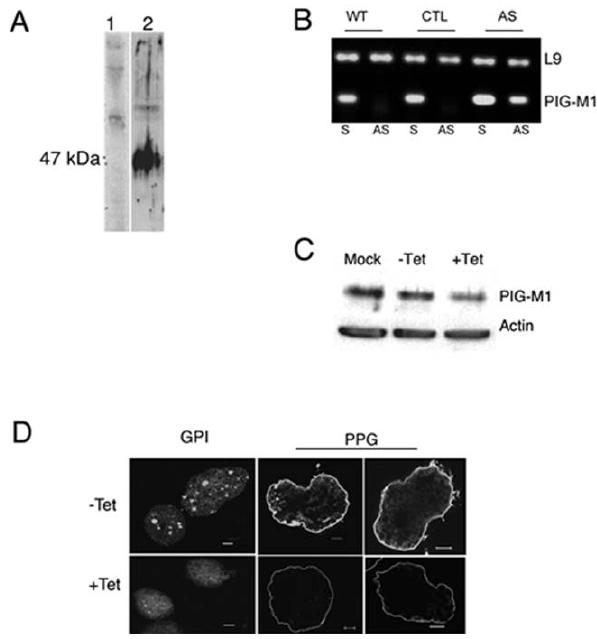
Figure 2. Expression of EhPIG-M1 in E.histolytica WT and anti- sense strains. A. Protein analysis by immunoblot of extracts of wild type parasites. Electrophoretic resolution in 8% PAGE and immunoblots of proteins from a crude extract (equivalent to 10 4 cells by lane). Proteins were probed by immunoblot with pre-immune serum (lane 1) and with a anti-EhPIG-M1 antibody (lane2). B. Cloning and expression of anti-sense mRNA expressing parasites. The fragment cloned in anti- sense carries the first 708 bp of XM_64 49 88 loci. Agarose gel electrophoresis of PCR amplified products showed an unique DNA fragment (56 bp) amplified with antisense detecting primers when RNA was purified from PIG-M-AS strain. Antisense RNA was indeed absent from the wild type strain (WT) and from the control strain (CTL), which carries the vector. All strains allow for amplification of the sense mRNA. L9 correspond to ribosomal protein L9 encoding mRNA used as a control (81 bp). No amplification was detected for the two amplicons when RT was absent in the assay. S=sense detecting primers, AS=anti- sense detecting primers. C. Western blot analysis of protein lysates separated in SDS-PAGE. Extract from PIG-M-AS parasites ( + / 2 tetracy- cline) were used (equivalent to 10 4 cells by lane). EhPIG-M1 is at 47 kDa, and actin used as a blot reference at 43 kDa. The ECL film image was treated with ImageQuant software. D. Labeling of GPI-linked molecules by FLAER and PPG by immunofluorescence. PIG-M-AS cells grow with or without Tet were incubated with FLAER and treated for confocal microscopy. Upper left panel: FLAER labeled uninduced cells. Lower left panel: FLAER labeled induced cells expressing antisense mRNA, notice the loss of vesicle labeling. To localize PPG , PIG-M-AS trophozoites growing in the presence (or not) of tet for 5 days were fixed and incubated with specific mAb-5 recognizing PPG and treated for confocal microscopy. The micrograph (taken at the middle of the cell) shows a reduction of PPG labeling when the AS-cells were treated with tet. Notice the lost of spike-like structures around the cell. Bar=5 m.